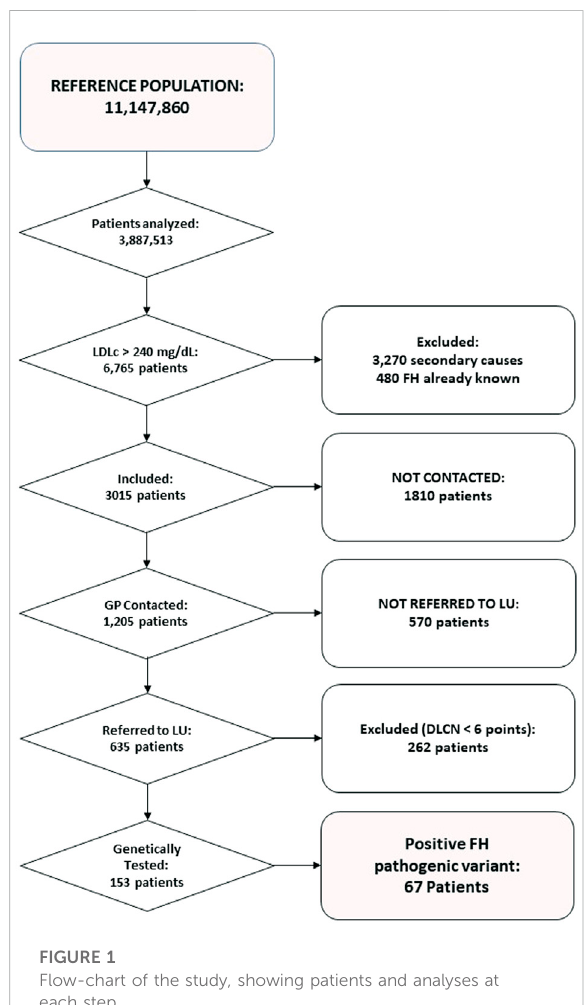
FIGURE 1 Flow-chart of the study, showing patients and analyses at each